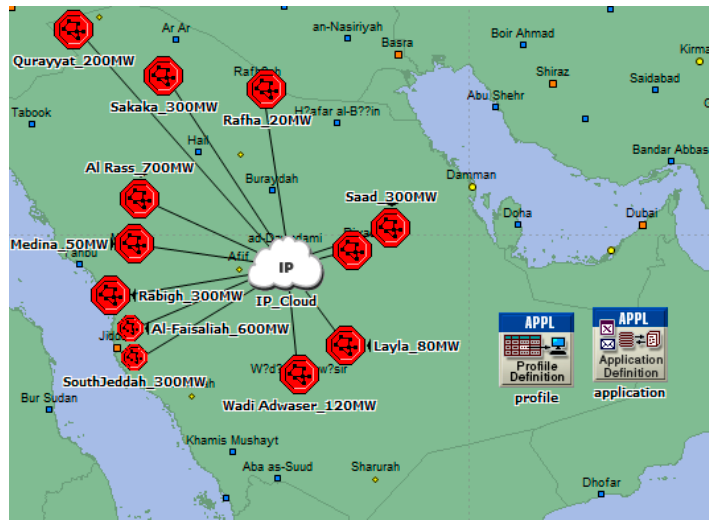
Figure 8. OPNET simulation model for grid integration of PV power plants.